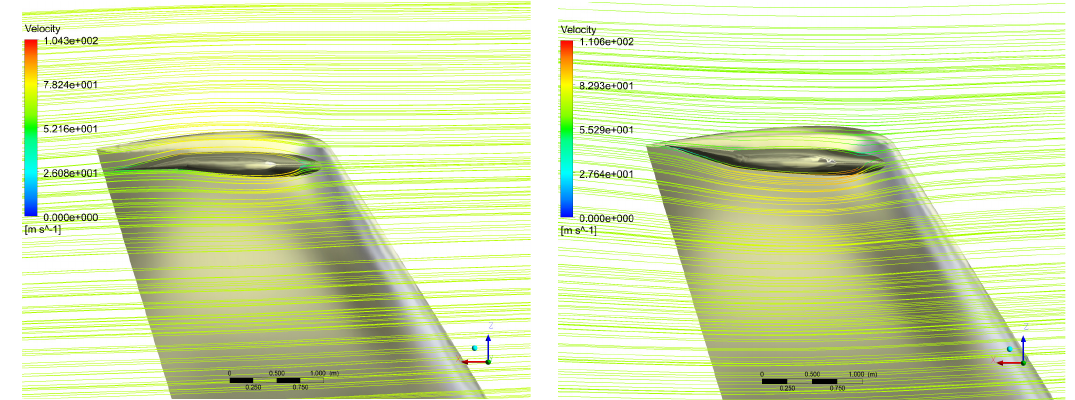
Figure 23. Elevators: mean flow streamlines at half-span plane for δ e = + 10 ◦ ( left ) and − 10 ◦ ( right ). The spanwise loading distribution on both aircraft wing and horizontal tailplane, for the flight condition at M ∞ = 0.2, is shown in Figure 24 (left side). The maximum load on the horizontal tailplane occurs away from the symmetry plane, due to the presence of the vertical fin. The load on the horizontal tailplane decreases with the Mach number, as illustrated on the right side of the same figure. The variation of the pitching moment coefficient against the AoA is reported in Figure 25. When the elevator is not deflected ( δ e = 0 ◦ ), apparently, the horizontal tailplane provides a negative lift that corresponds to C m > 0, for almost all AoA. This is due to its negative incidence with respect to the aircraft centerline ( i h < 0), along with the downwash effect from the aircraft wing. Deflecting the elevator by − 10 ◦ (upward) increases the absolute value of the negative lift. On the other hand, deflecting the elevator by + 10 ◦ (downward) provides a positive lift, which gives in absolute value lower loading on the horizontal tailplane.